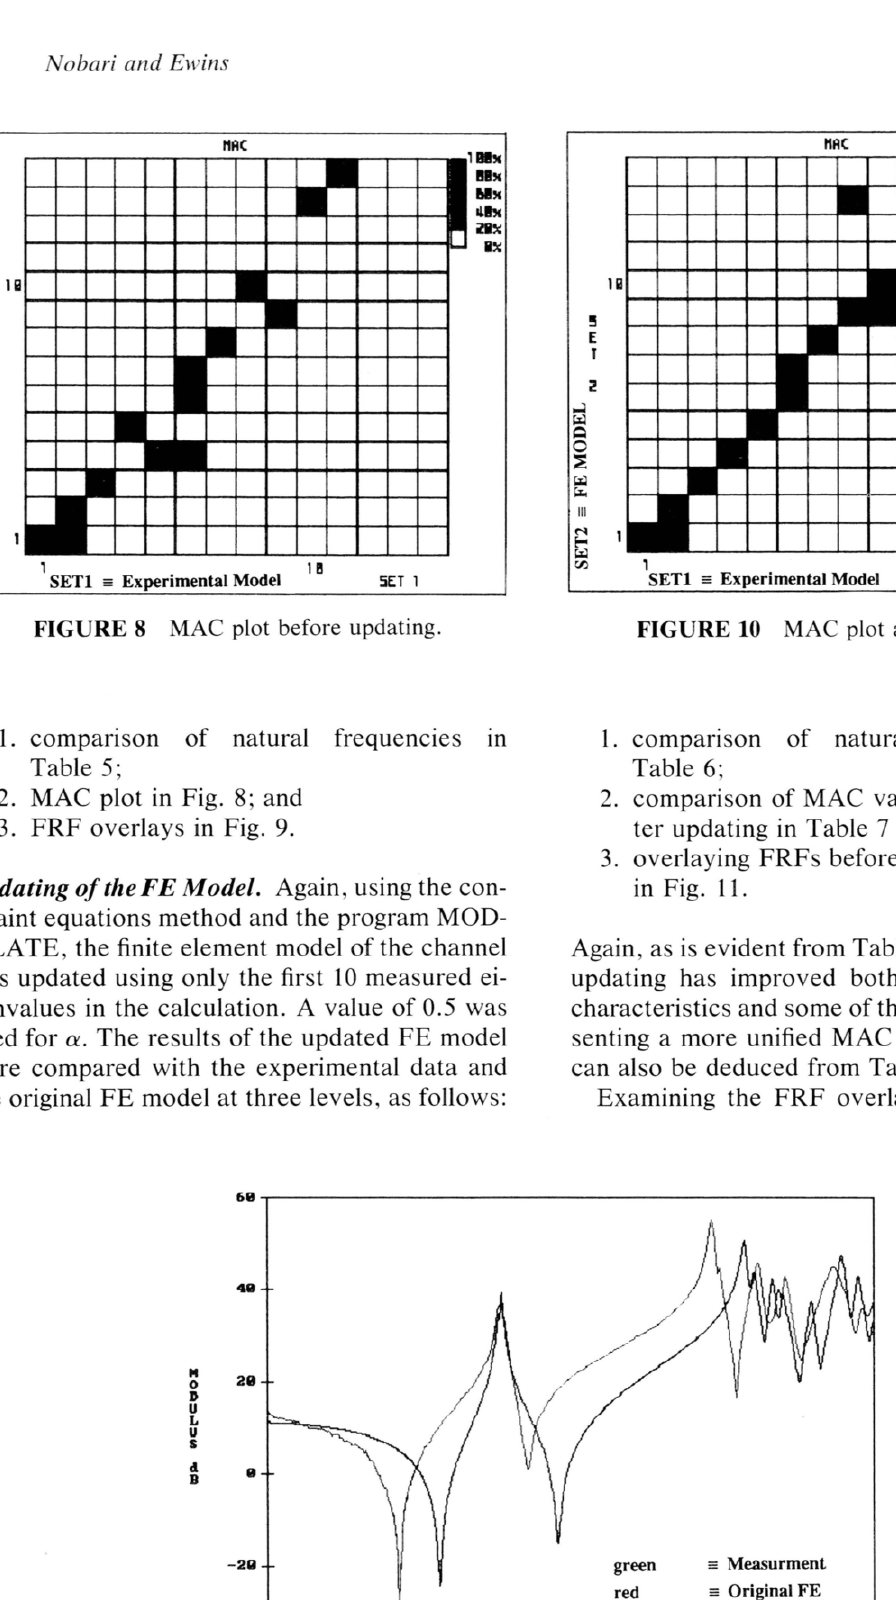
FIGURE 9 Measured and original FE point FRFs